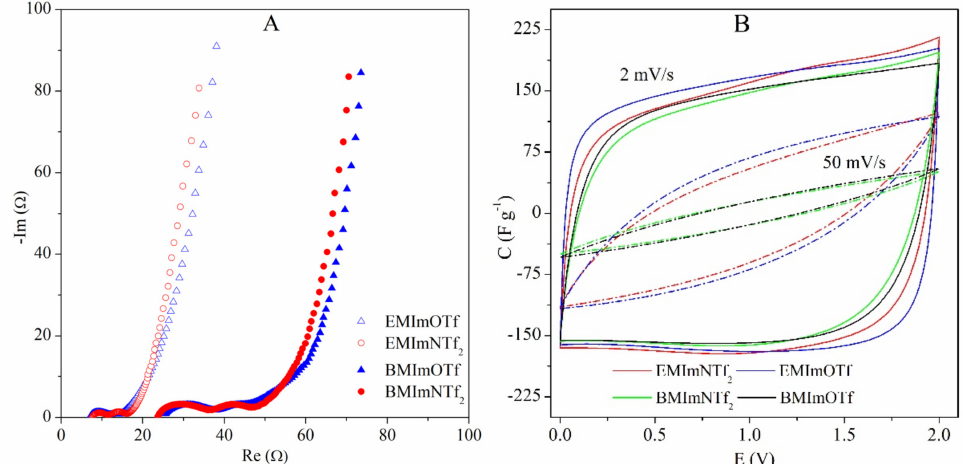
Figure 7. ( A ) Nyquist plot at open-circuit voltage and ( B ) CVs (at 2 and 50 mV s − 1 ) of the AC/AC capacitors with the various ionogels with 70 wt.% of